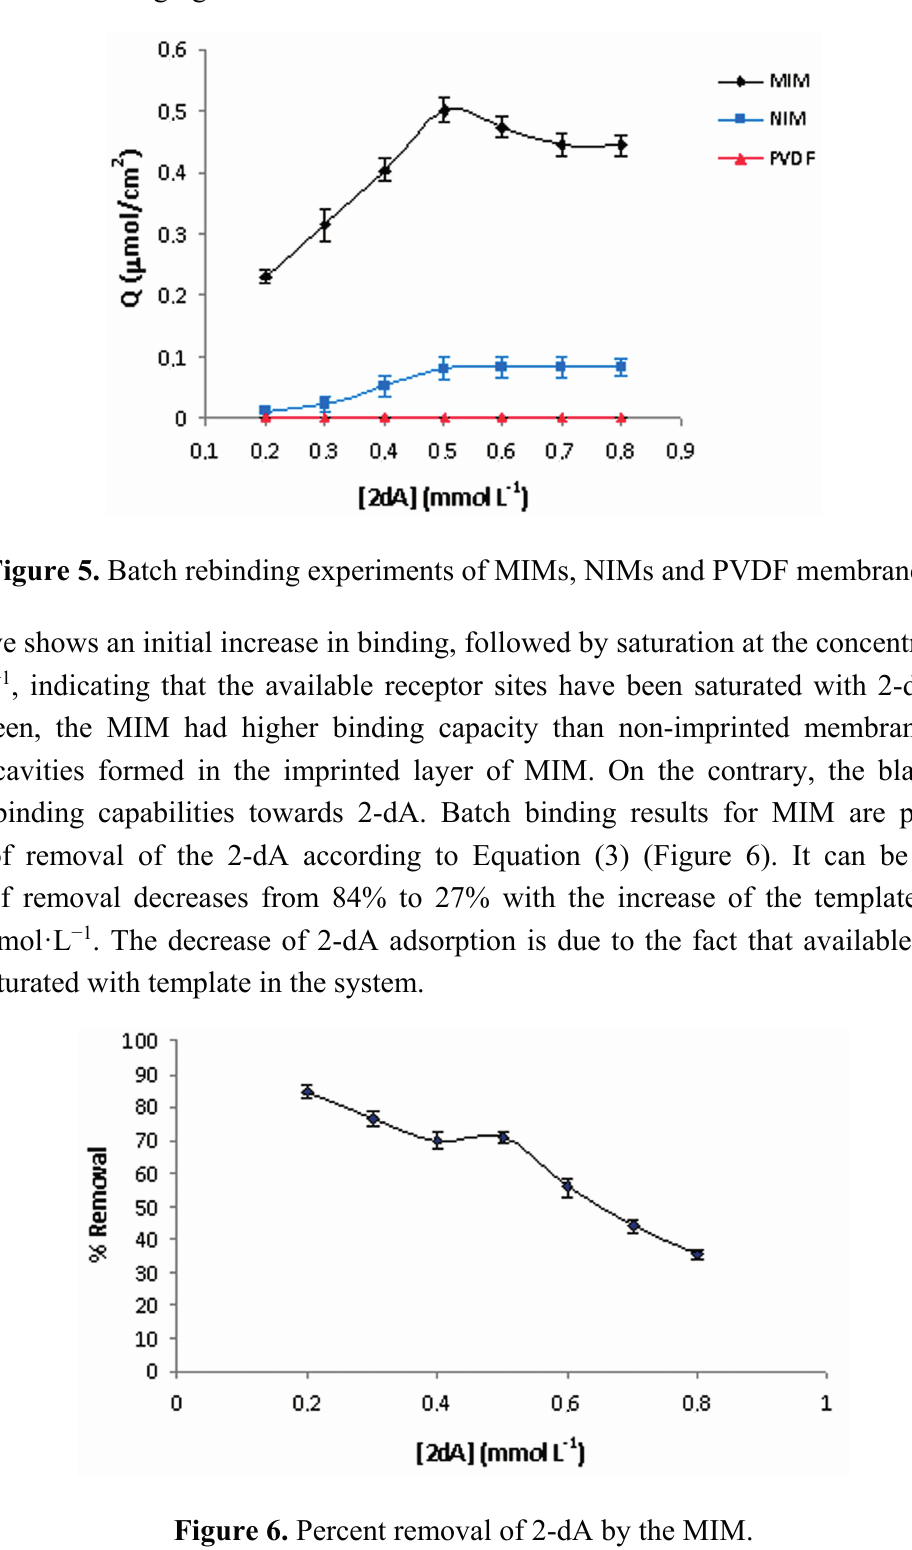
Figure 6. Percent removal of 2-dA by the